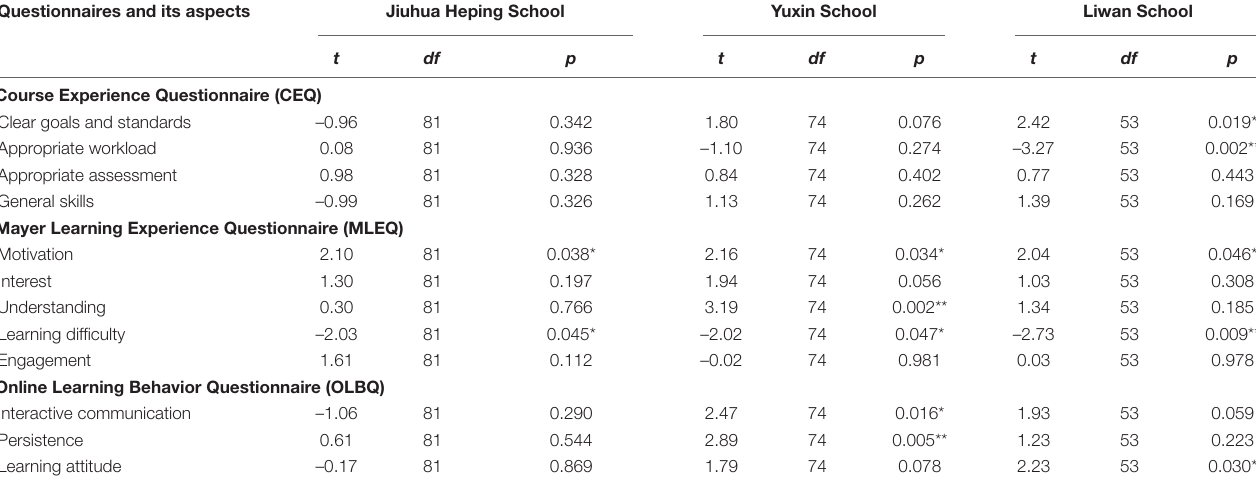
TABLE 4 | Independent t -test results of two assessments on each dimension of the three questionnaires in three schools. Questionnaires and its